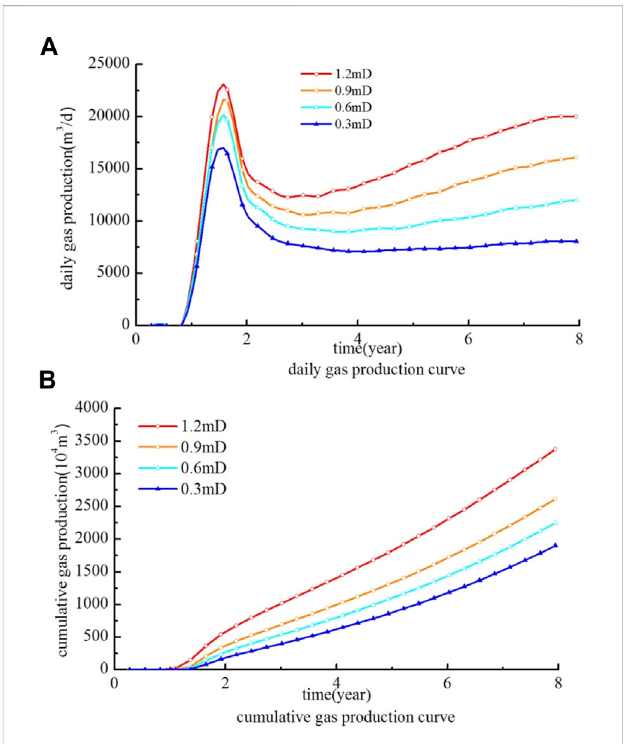
FIGURE 3 Gas production curve under different permeability conditions. (A) Daily gas production curve, (B) Cumulative gas production